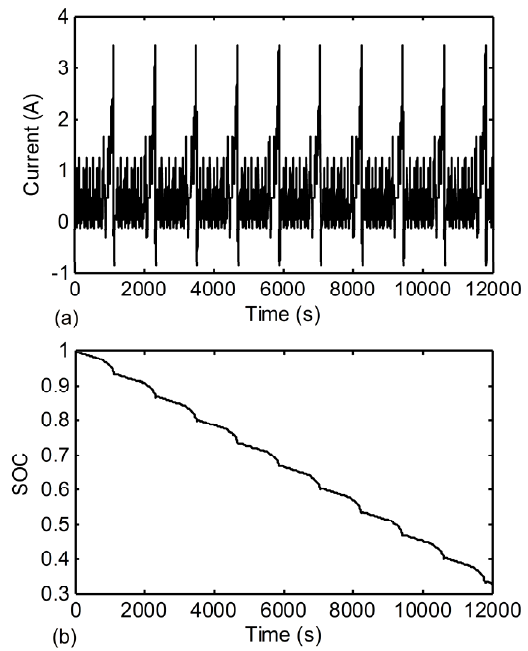
Figure 8. Current and SOC under NEDC (New European Driving Cycle) test: ( a ) current; ( b )